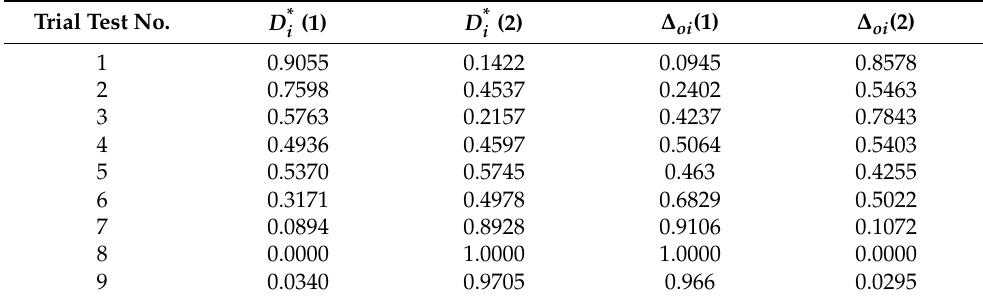
Table 3. For displacement and stress, the larger displacement is better and the smaller stress is better, and ∆ oi (1) and ∆ oi (2) show value